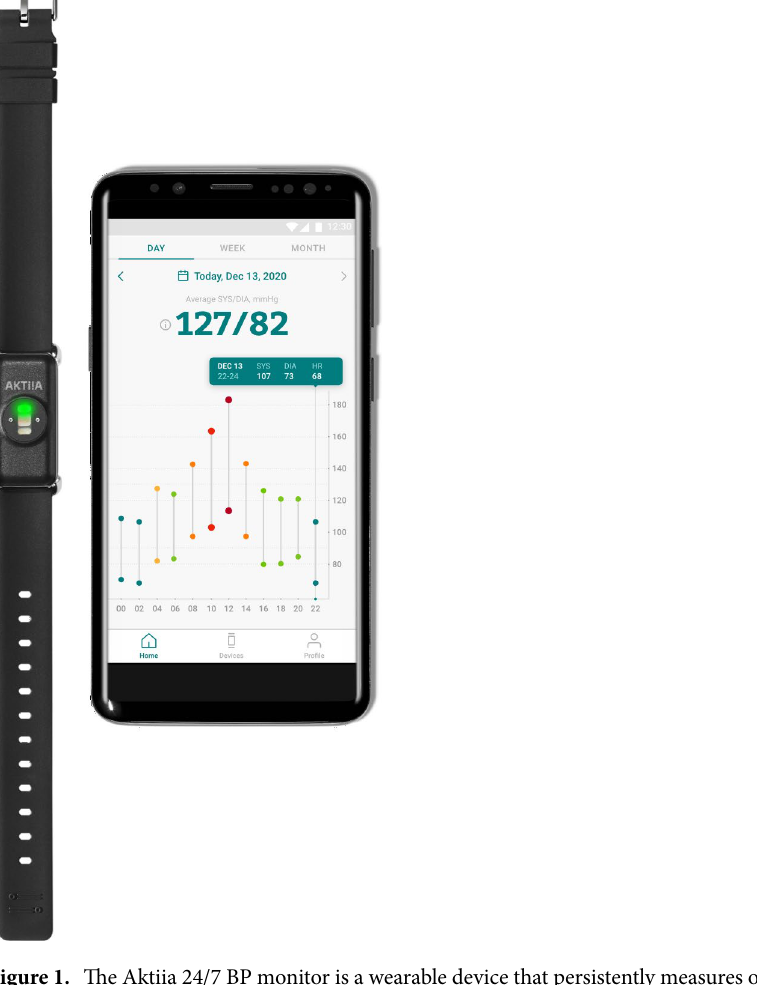
Figure 1. The Aktiia 24/7 BP monitor is a wearable device that persistently measures optical signals on the skin vasculature of the wrist and displays day and night BP values on a companion smartphone application. The Aktiia Bracelet is a CE-marked class IIa medical